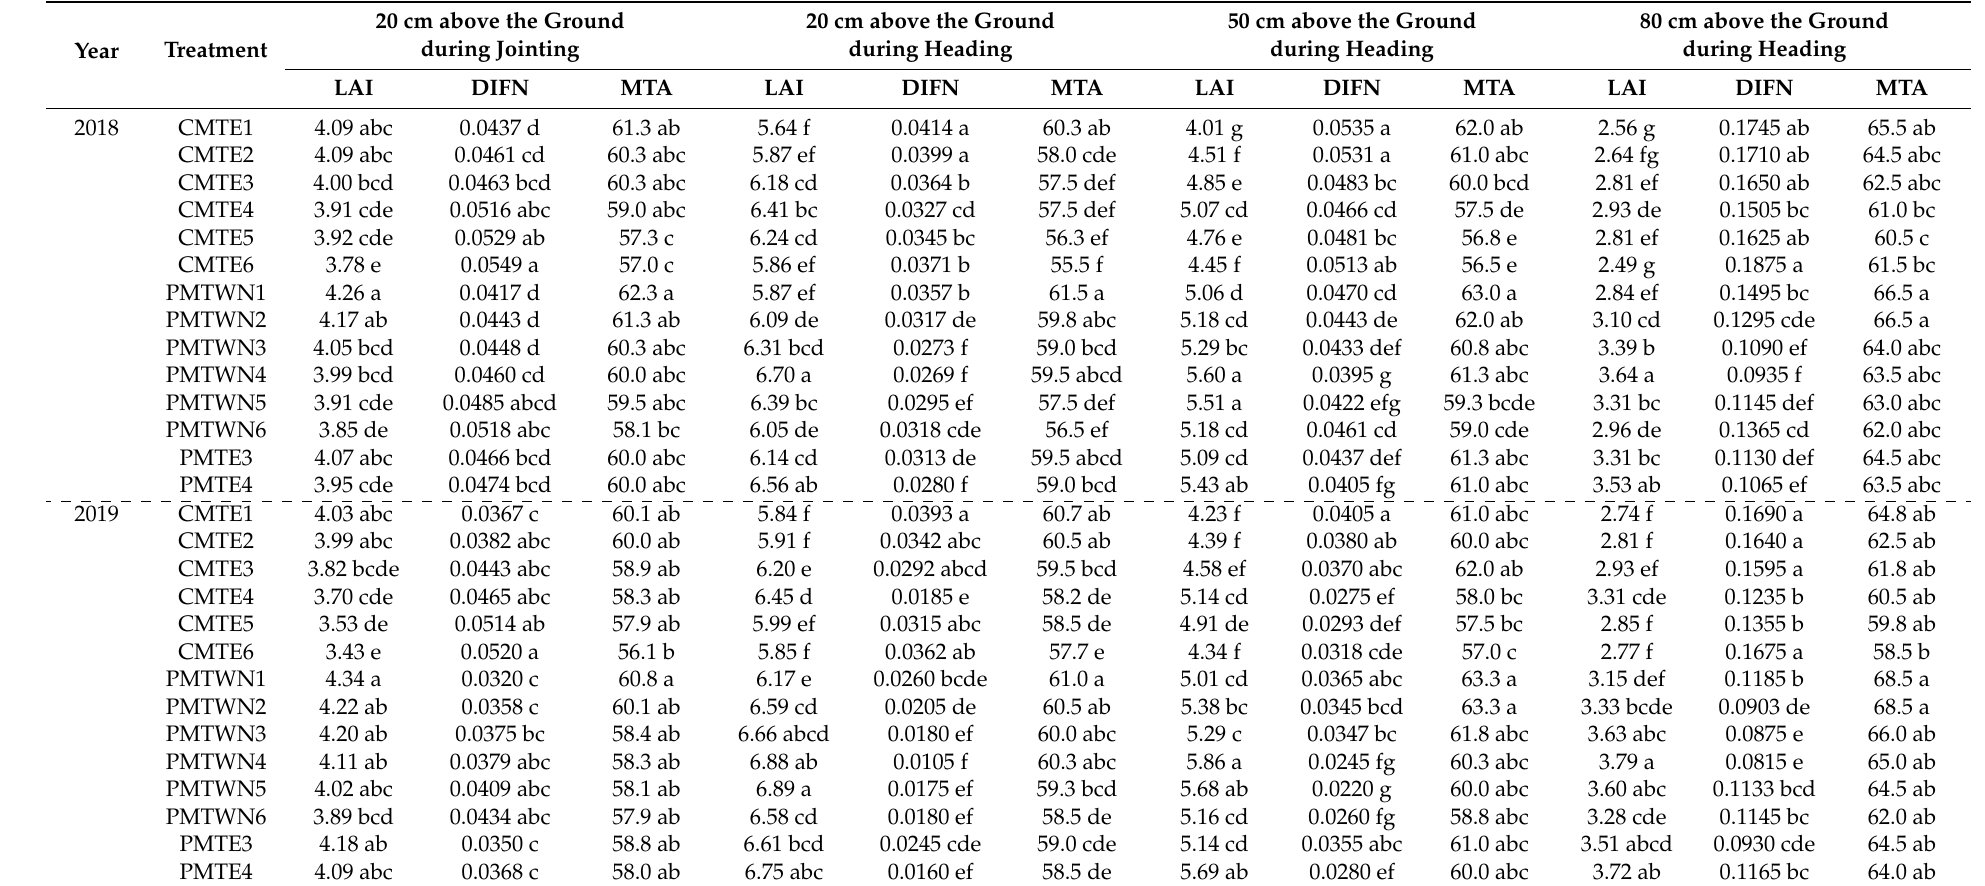
Table 8. The canopy structure of rice under different mechanical transplanting methods and planting